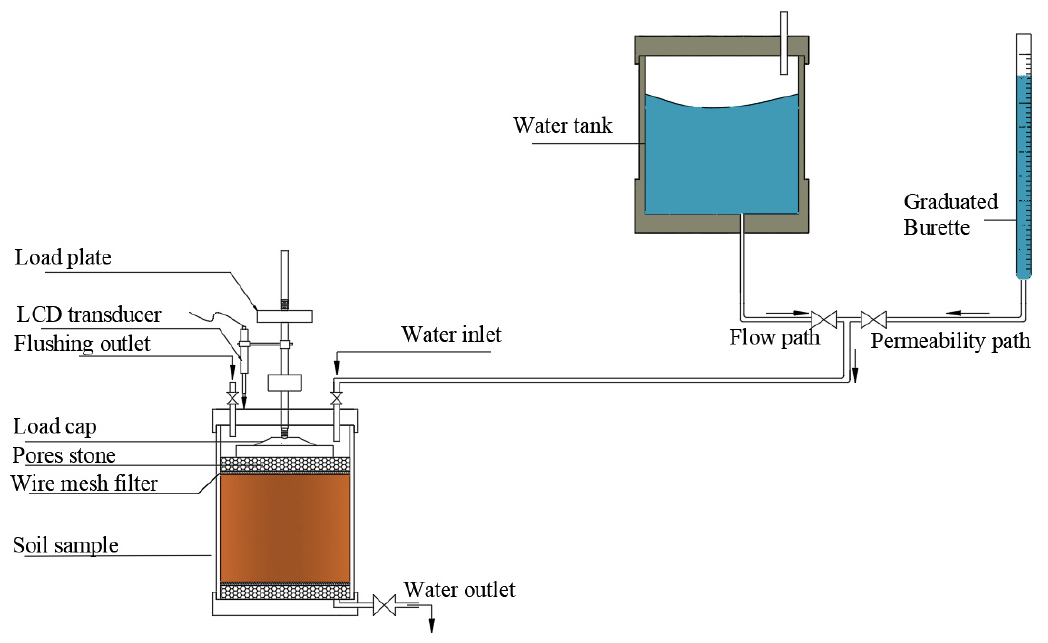
Figure 3. Schematic diagram of the testing setup.